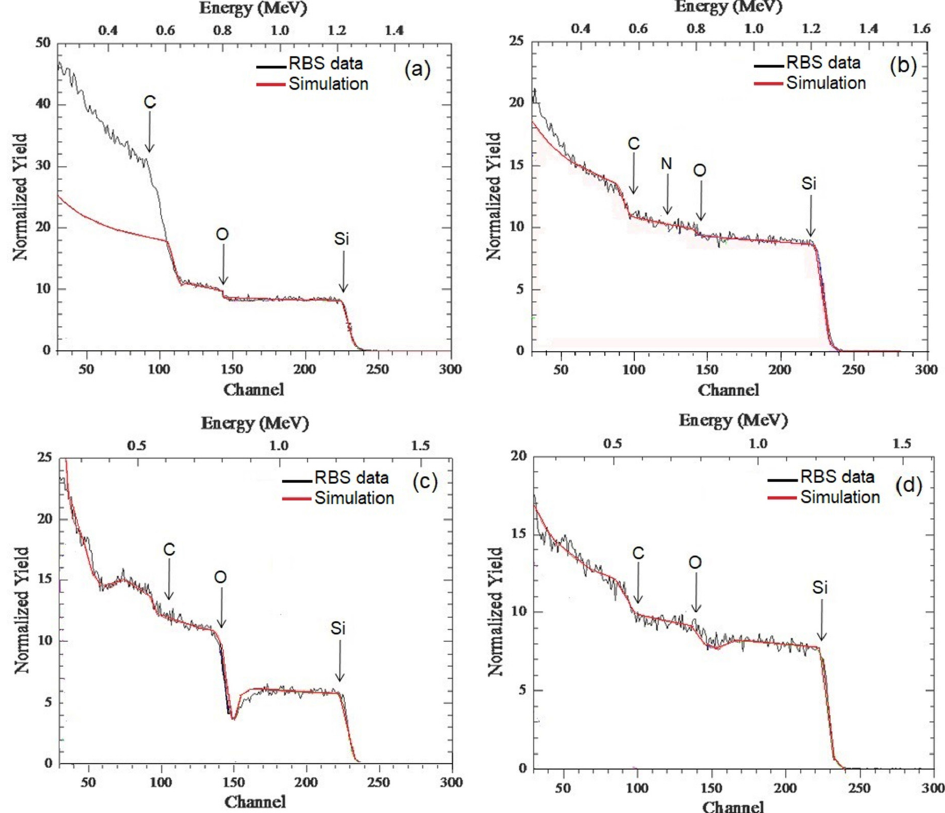
Figure 1. Experimental and simulated Rutherford backscattering spectrometry (RBS) spectra of the SiC films deposited on ( a ) Si substrate at 200 W; ( b ) Si substrate at 400 W; ( c ) AlN/Si substrate at 200 W and; ( d ) AlN/Si substrate at 400 W.